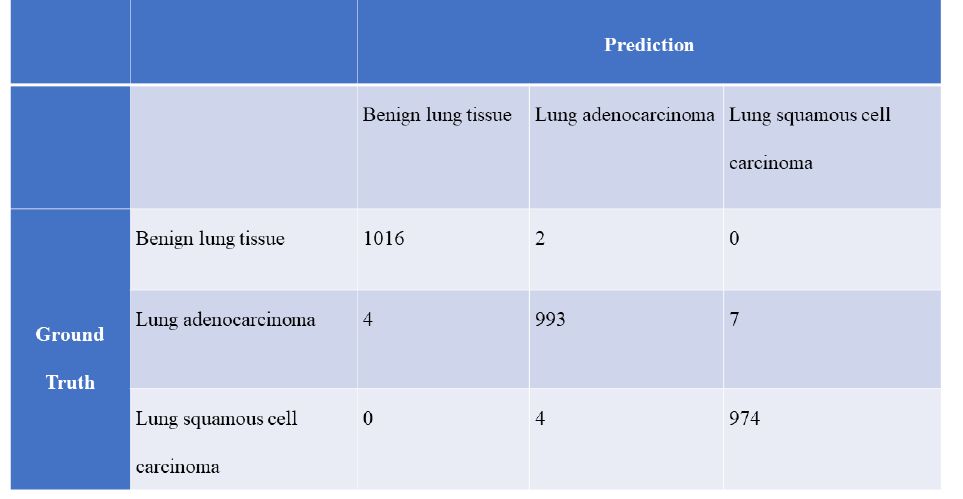
Figure 7. Confusion matrix between the ground truth and prediction obtained with the optimal CAD system in the public dataset.